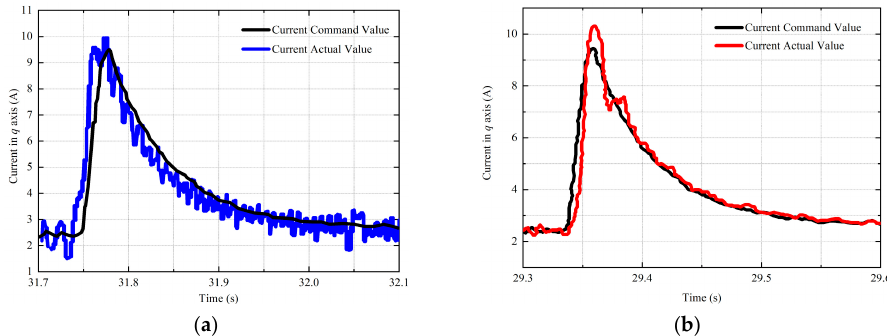
Figure 11. Current response in q axis when speed command suddenly changed from 2000 rpm to 3000 rpm. ( a ) Current response based on conventional method; ( b ) Current response based on deadbeat current predictive method.